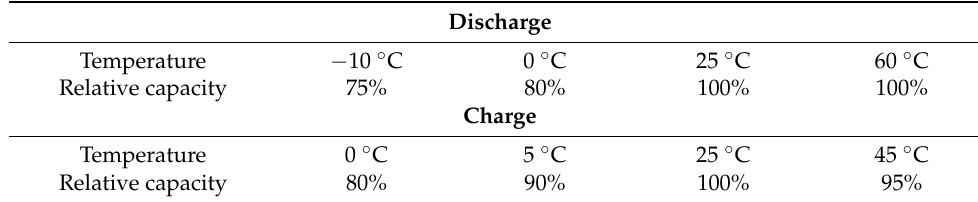
Figure 8. Battery cell model with 1 RC branch and thermal dependence. Table 7. Battery cell capacity dependency on temperature for discharge and charge processes.